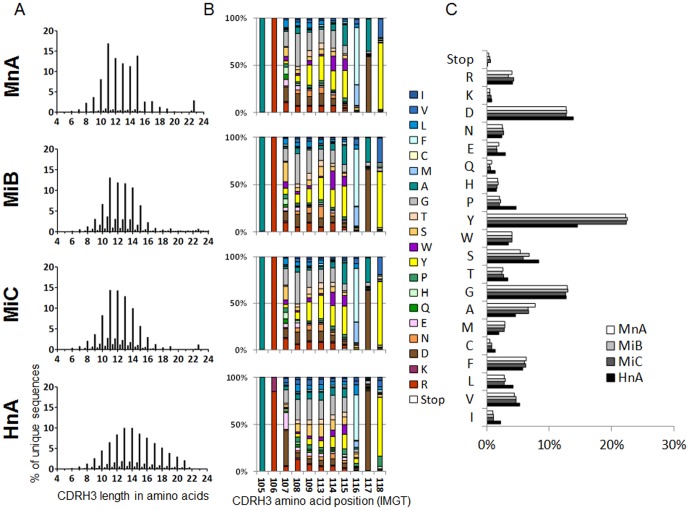
Characterization by NGS of captured murine and human CDRH3 repertoires.(A) Length profile of CDRH3 represented as the percentage of unique CDRH3 in function of their length in amino acids (AA). The minor peaks in between integers correspond to sequences where a frame shift occurred. (B) AA composition profile of unique CDRH3 of 11 AA, the most common length in murine diversity according to (A). For each position in the CDRH3, the percentage of AA was defined and illustrated according to a color code. IMGT numbering was followed to refer to AA positions. (C) AA composition profile of unique CDRH3 all lengths considered. The few stop codons found are likely due to cloning or NGS errors.